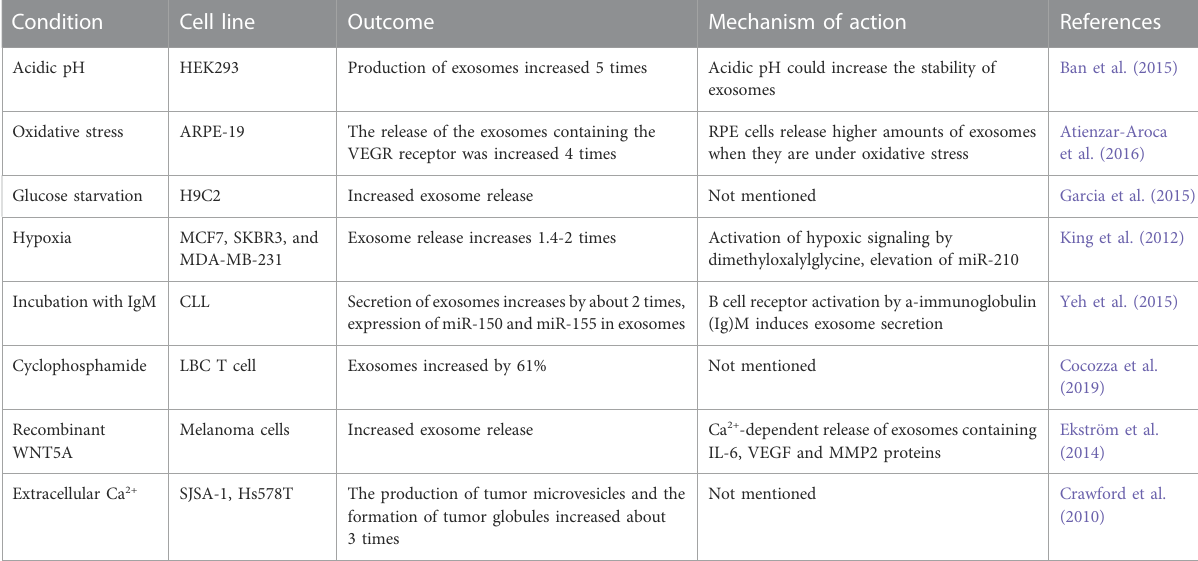
TABLE 2 Physical or chemical methods promote the release of exosomes.